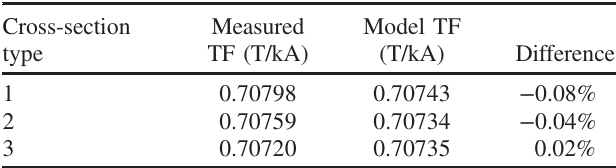
TABLE II. Measured and modeled transfer function (TF) for the three LHC dipole cross section